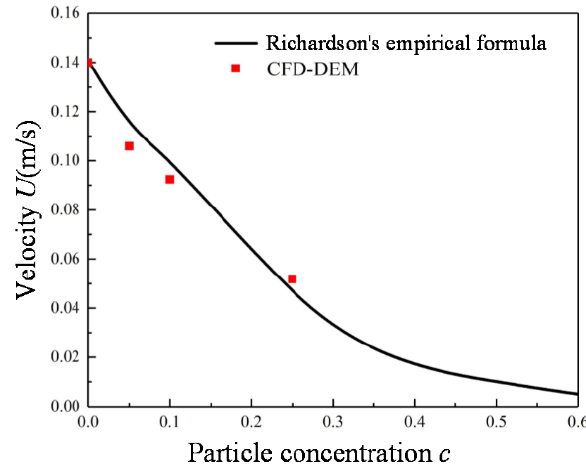
Figure 3. Variation of settling velocity of a uniformly sized spherical particle with the particle concentration.